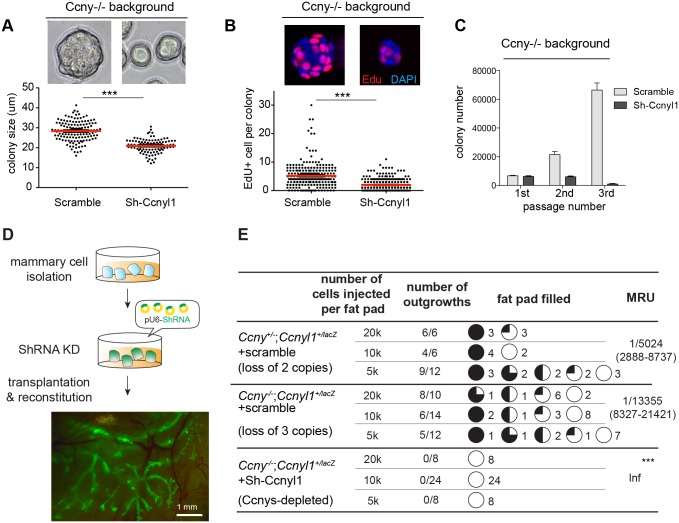
Depletion of Ccnys impedes basal stem/progenitor cell function in vitro and in regeneration.(A)
Ccny-/- mammary basal cells (Lin-,CD24+,CD29hi) were FACS-isolated from two 8-week-old mice, infected with lentiviral Scramble- or Ccnyl1-shRNA, and cultured in Matrigel. Colony sizes were measured at culture day 6. Shown data are representative of three independent experiments. Data are presented as mean±s.e.m. Student’s t test: ***p<0.001. (B) EdU labeling of basal colonies. 10 uM EdU of final concentration were added to the culture medium for 30 minutes. The colonies were then used for EdU staining. Data are presented as mean±s.e.m. Student’s t test: ***p<0.001. (C) Basal colonies were serially passaged and their numbers were quantified. (D) Illustration of the transplantation assays. A typical result of mammary outgrowth is shown. (E) All mammary epithelial cells were sorted out from 8 to 12-week-old mice and infected with lentivirus. After a 6-day culture, virally infected mammary cells of the indicated genotypes were FACS isolated based on GFP and transplanted by limiting dilution. Recipient fat pads were harvested at 8 weeks post transplantation. The mammary outgrowth numbers and sizes (shown as percentage of fat pad filled) are combined from three independent experiments. The mammary reconstitution unit (MRU) frequency is shown for each group. Inf represents infinitely small. Student’s t-test: *** p<0.001.